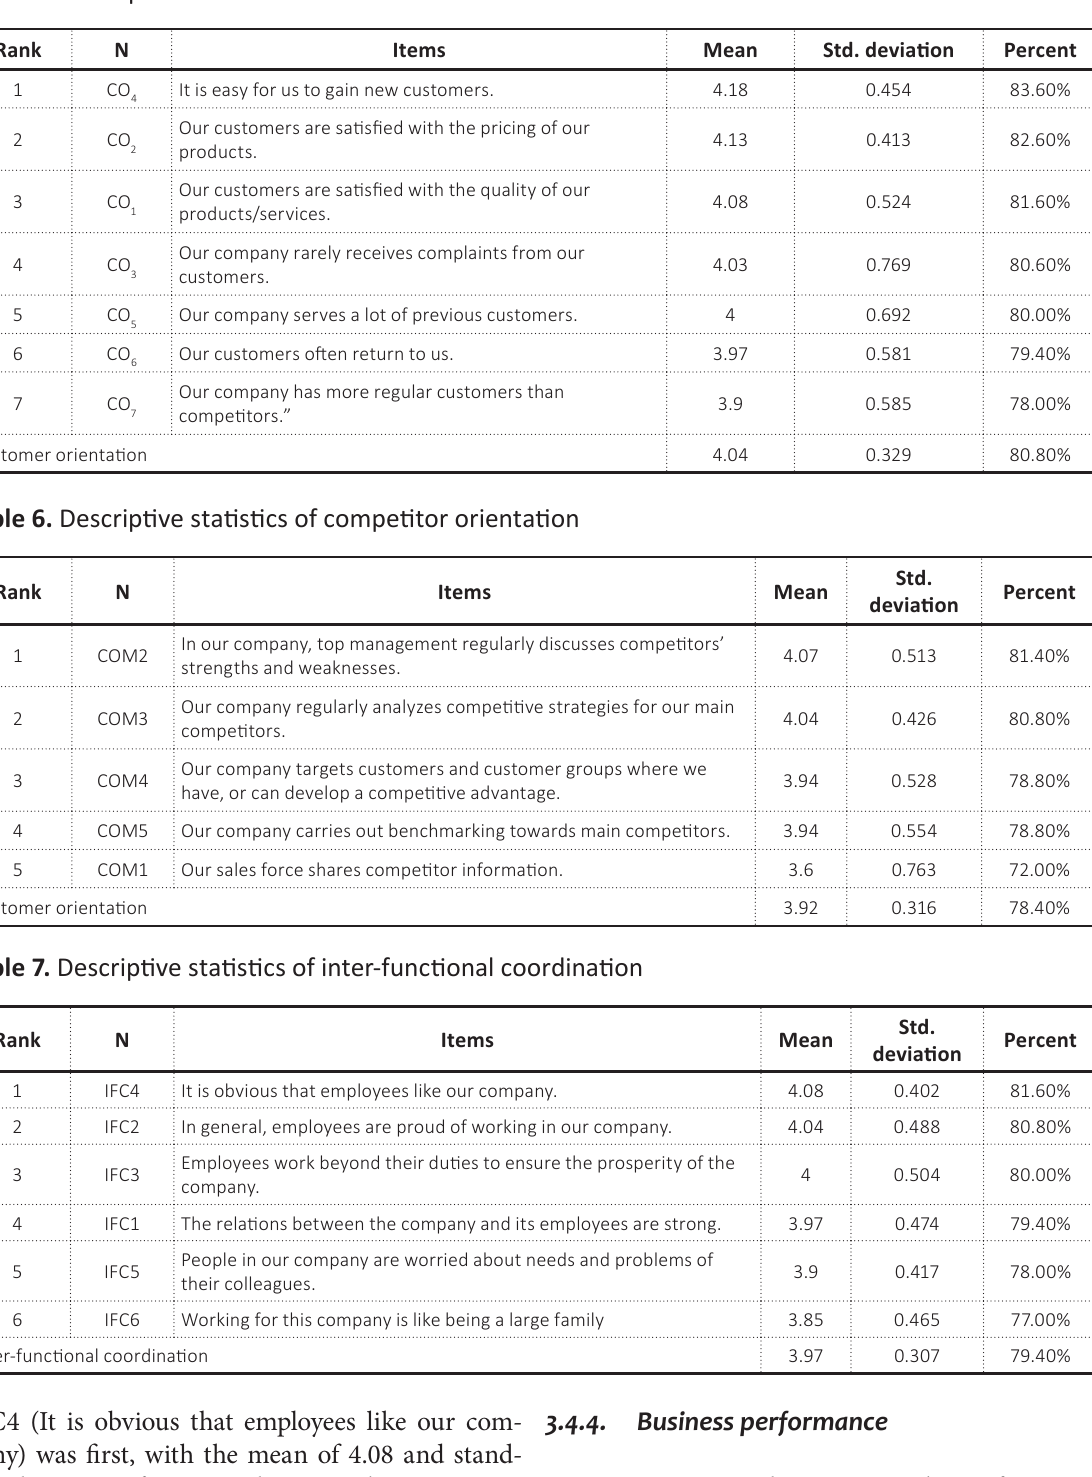
Table 5. Descriptive statistics of customer orientation